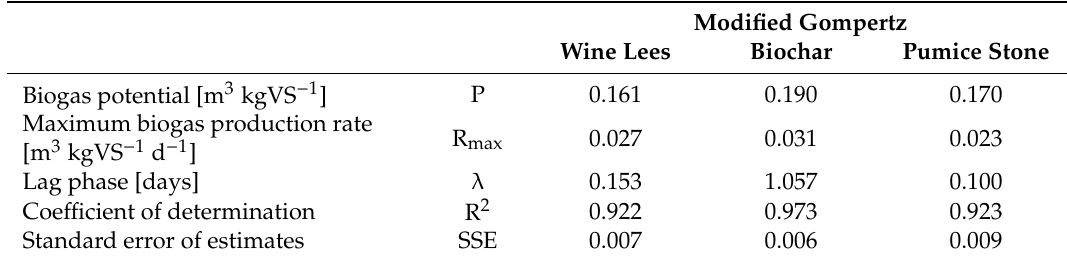
Table 6. Kinetic parameters obtained from fitted data to the Gompertz model. Results from batch AD tests of WL with biochar and pumice